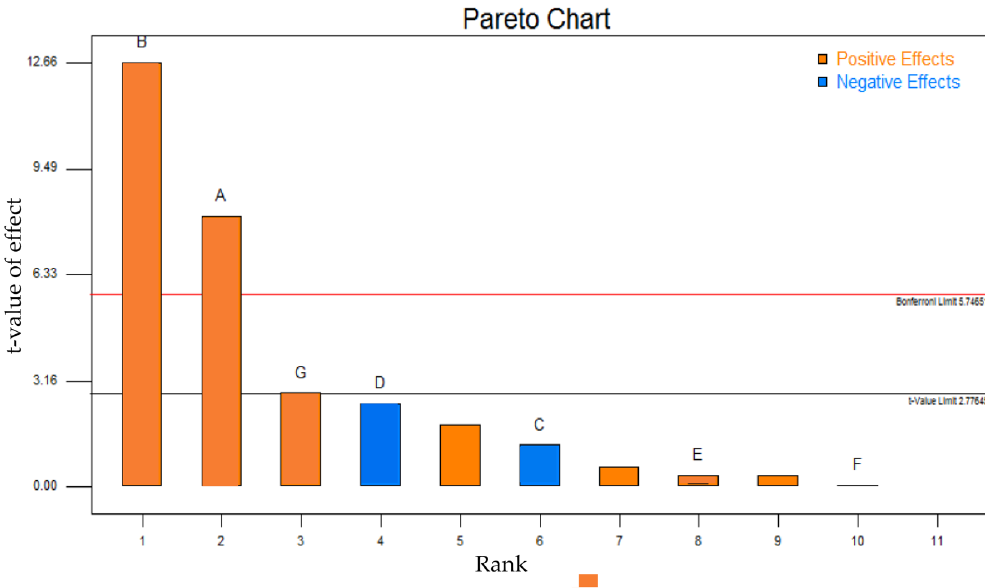
Figure 1. Pareto chart of standardized effects for the Plackett–Burman design of initial cell concentration ( A ), initial pH ( B ), MnSO 4 .H 2 O ( C ), ZnSO 4 .7H 2 O ( D ), MgSO 4 .7H 2 O ( E ), KH 2 PO 4 ( F ), and yeast extract ( G ).